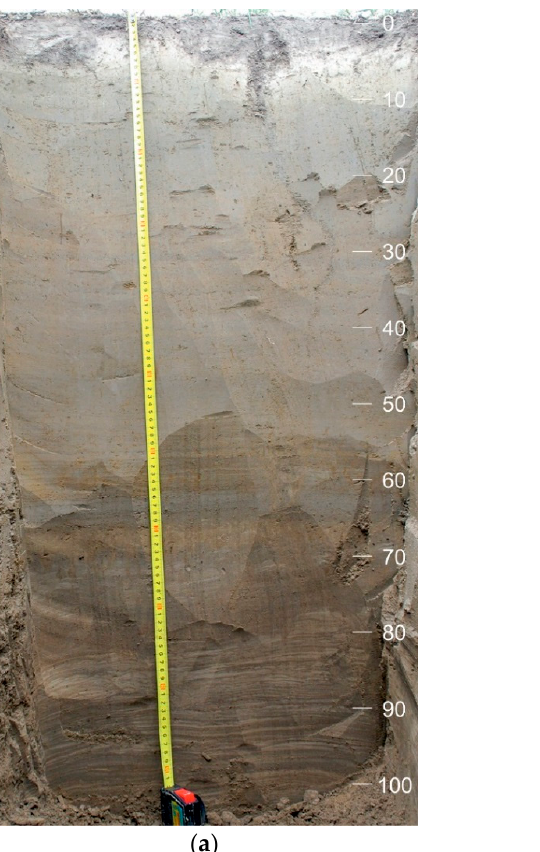
Figure 3. Photos of the experimental sites of the upper ( a ) and middle ( b ) zones of alas.